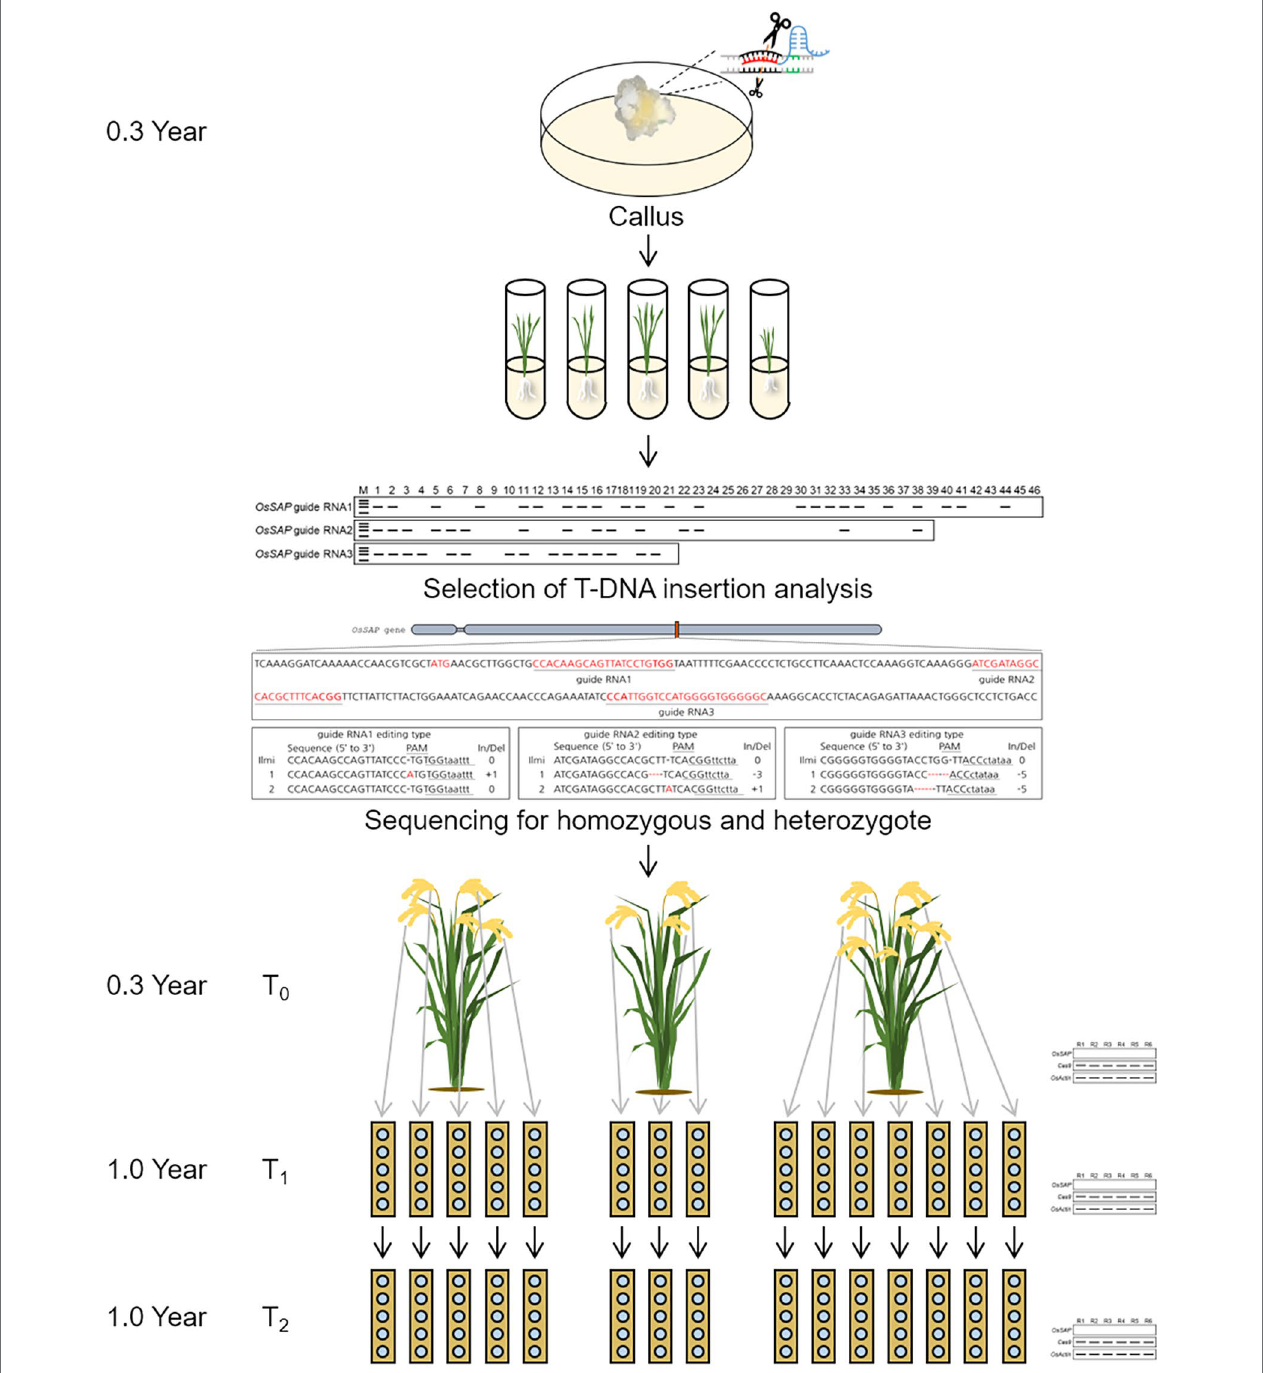
FIGURE 7 | Scheme of short breeding cycle using CRISPR/Cas9 in rice. Agrobacterium -mediated transformation used for genome editing with CRISPR/Cas9. In regenerated plants, a gene was selected and edited by T-DNA insertion and sequencing. On the T 0 plant, each spike is assigned a different accession number. T 1 plants are transplanted to one row for each line. T 2 seeds are harvested in